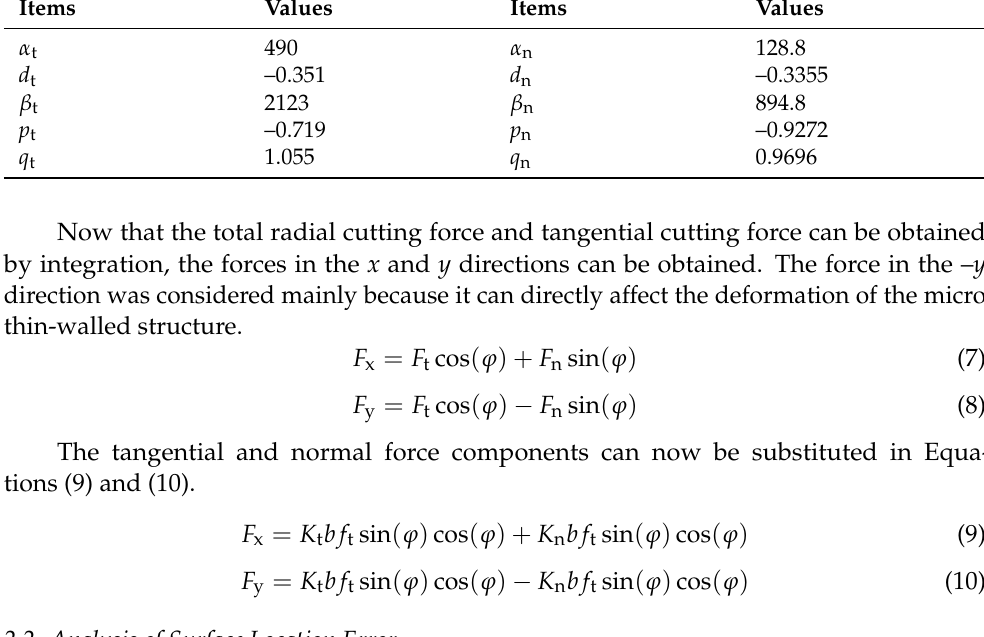
Table 1. Values of cutting coefficient for Al6061-T6.